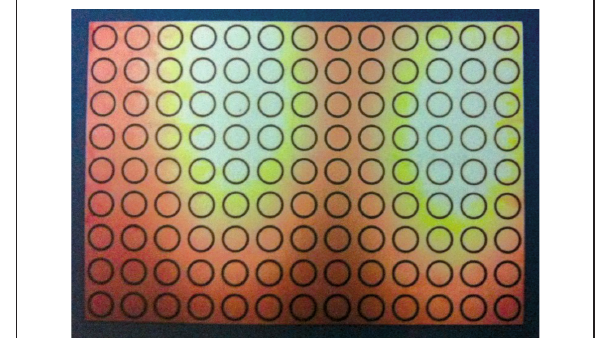
Figure 5. Results for the fi nite FSS simulated with a plane wave excitation. The electric fi eld amplitude is shown for three different points.